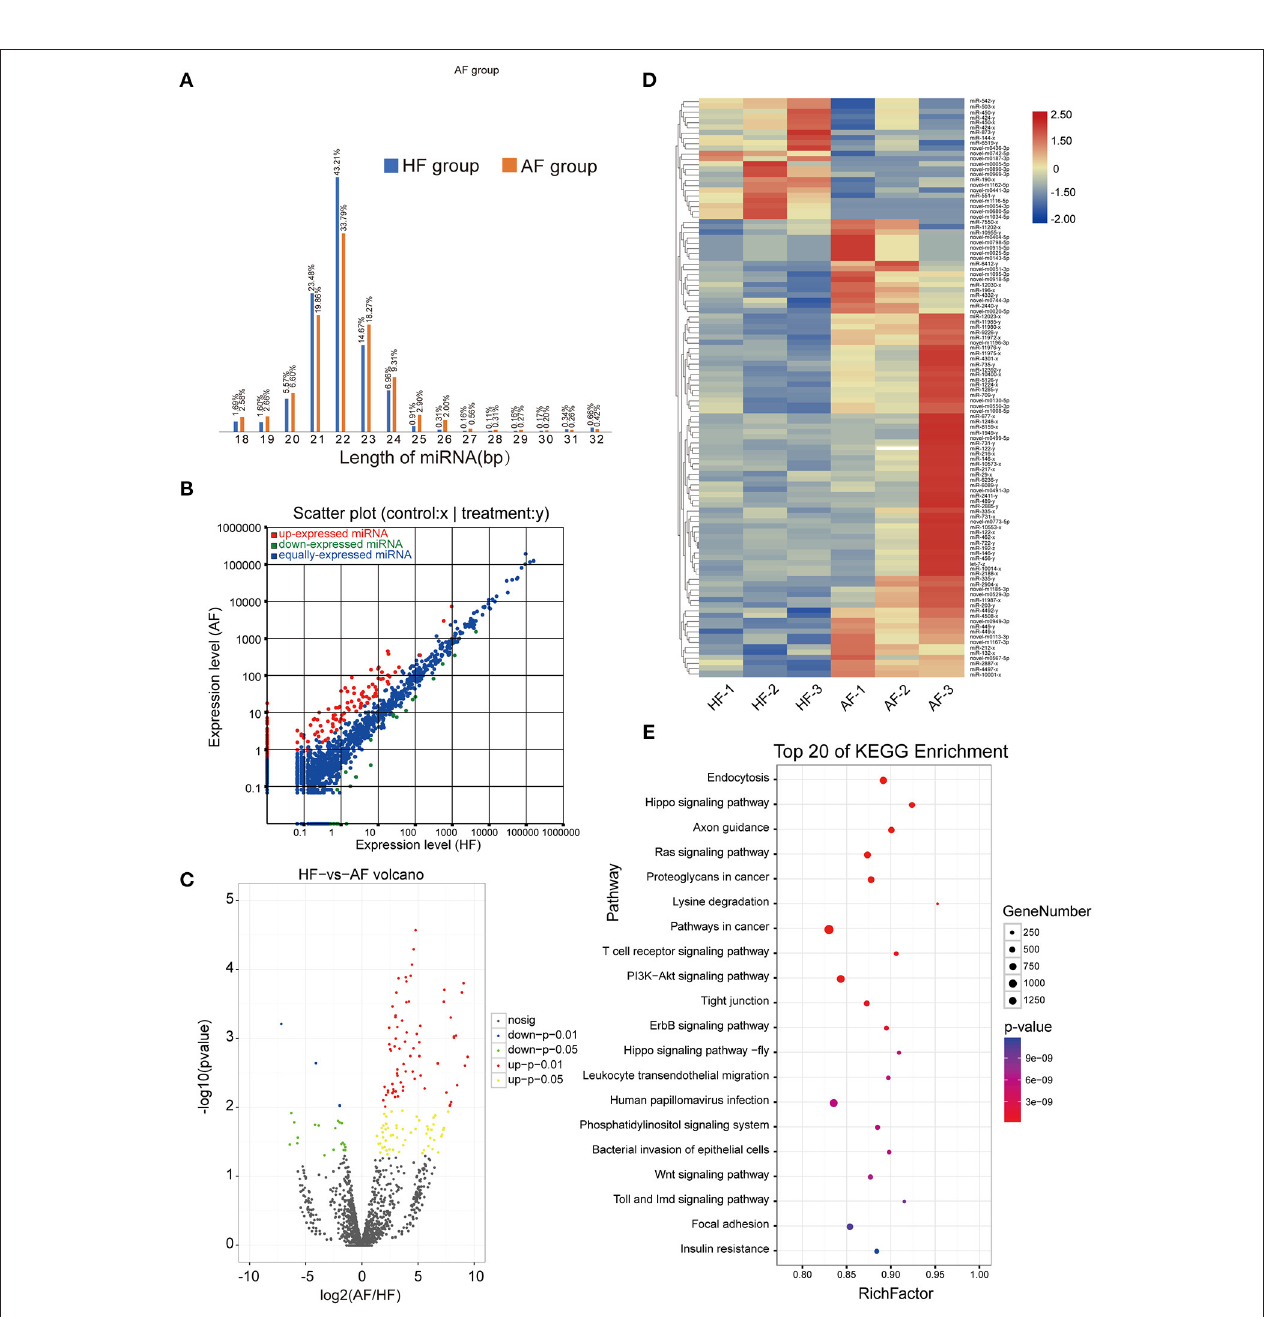
FIGURE 2 | expression of DEmRNAs was calculated with 2 as the base logarithm, and different samples and transcripts were analyzed by hierarchical cluster analysis; red and blue represent upregulation and downregulation, respectively. (D) Top 20 of the KEGG pathway bubble chart of DEmRNAs. The bubble size represents the number of mRNAs enriched in the pathway, and the bubble color represents the p -value. (E) GO enrichment histogram of DEmRNAs; blue and yellow represent upregulation and downregulation, respectively.